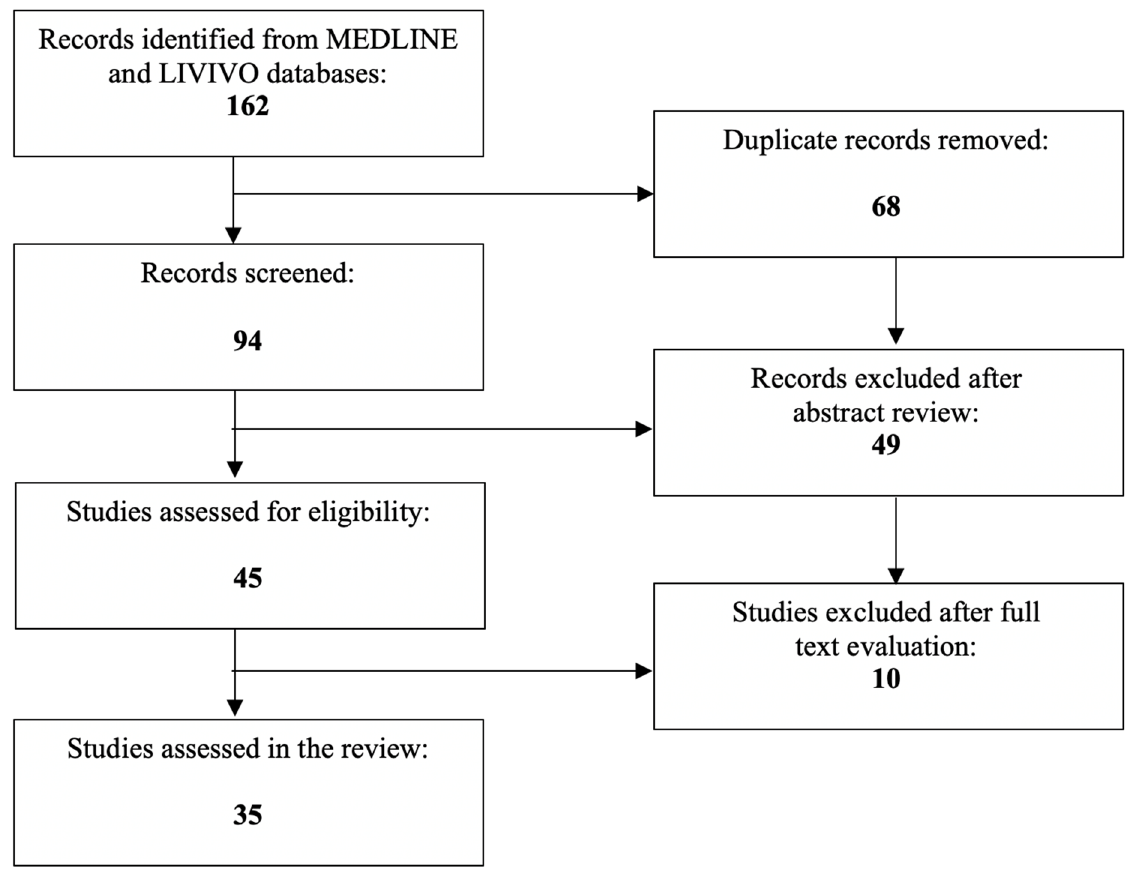
Figure 1. PRISMA flow diagram visually summarizing the screening